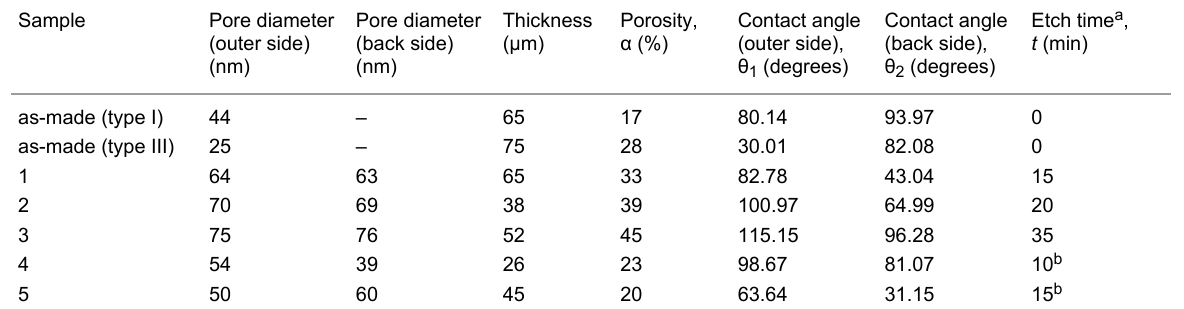
Table 2: Contact angle values for as-made PAMs obtained in 0.3 M oxalic acid (type I and type II) and values for samples 1–5 after etching of the barrier layer (all of type I).